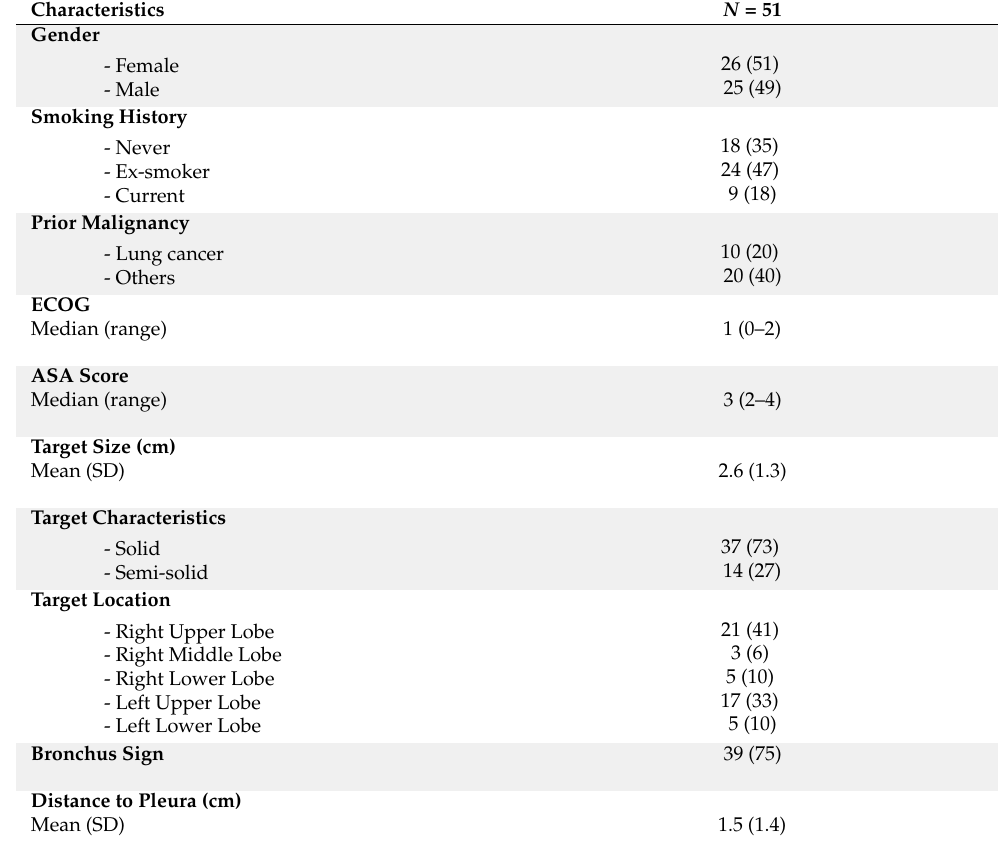
Table 1. Patient and target